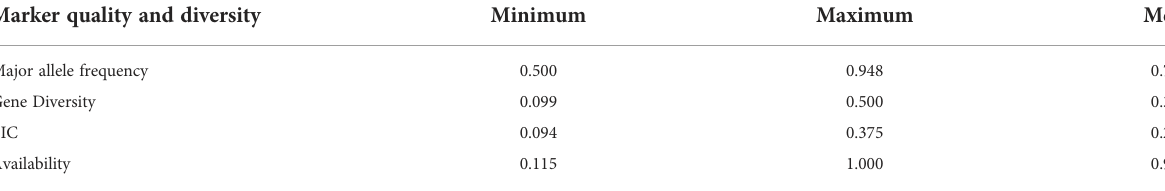
TABLE 2 Estimation of major allele frequency, gene diversity, PIC and